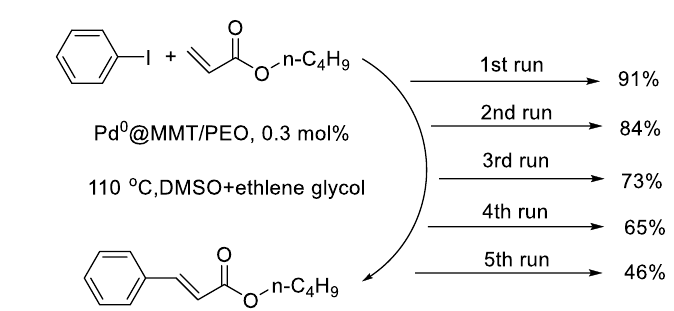
Figure 6. Recycling performances of the Pd 0 @MMT/PEO catalytic composites.